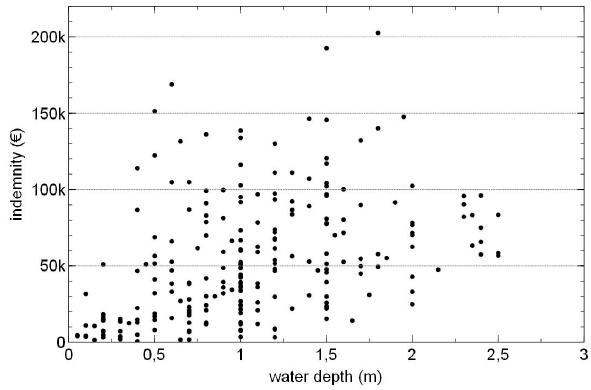
Fig. 5. Scatter plot of the Johanna and Xynthia storms records in the second-level database showing the causal relationship between indemnity for the main building and water